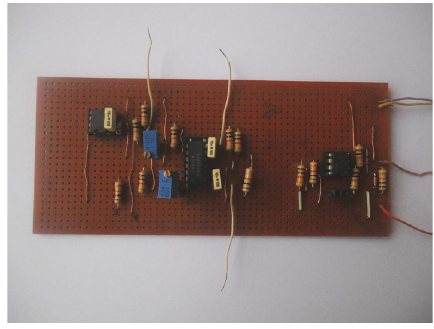
Figure 10: Real circuit implemented by using electronic components.